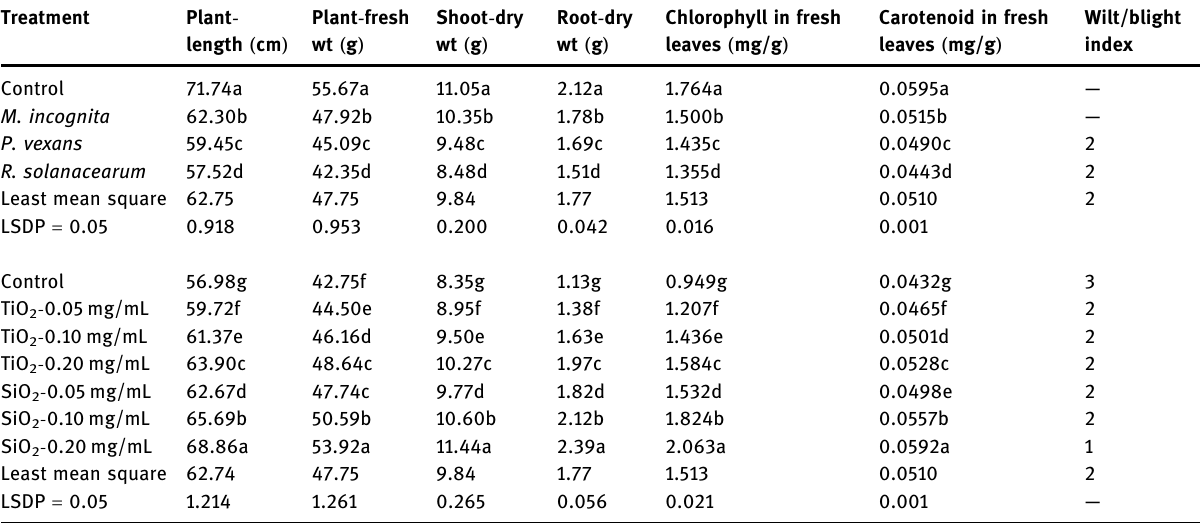
Table 2: E ff ect of SiO 2 - NPs, TiO 2 - NPs, P. vexans , M. incognita , including R. solanacearum on eggplant plant growth and photosynthetic pigments